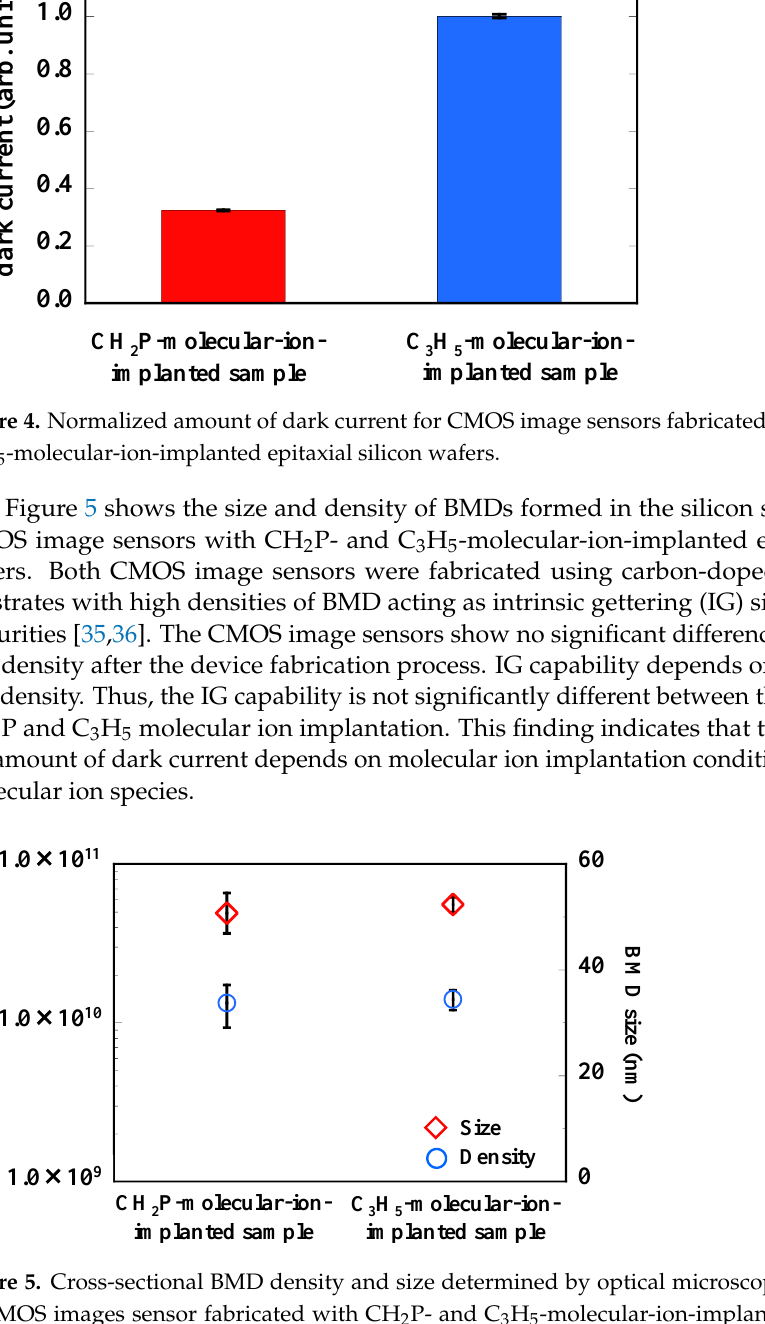
Figure 3. Dark current histogram obtained by DCS at 60 °C for CMOS image sensors fabricated with